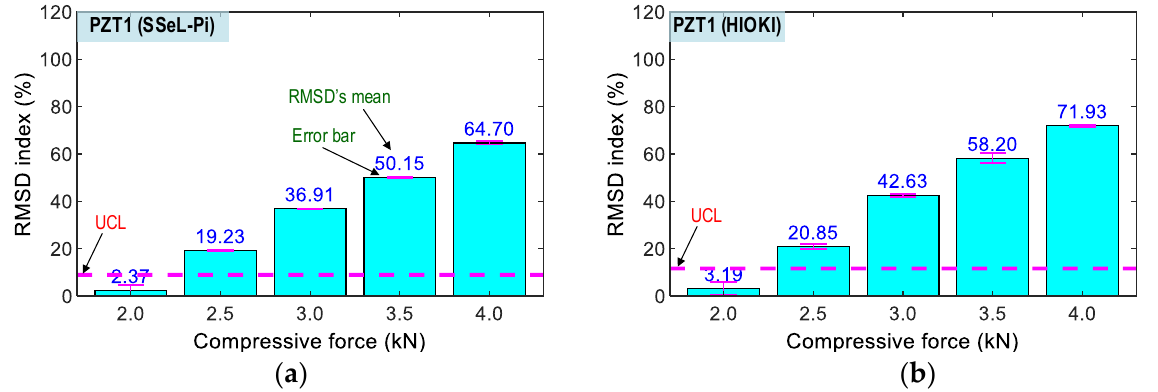
Figure 23. Impedance features of PZT 1 corresponding to compressive loadings P1 – P5. ( a ) SSeL-Pi, ( b ) HIOKI-3532.